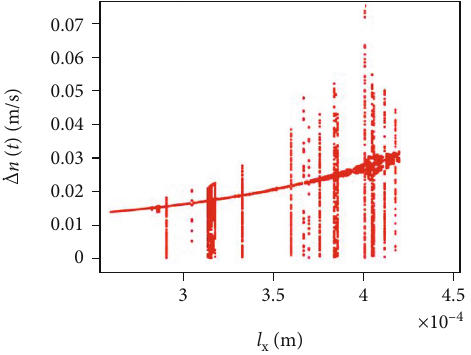
Figure 9: Bifurcation diagrams with the misalignment changing of the x direction when the misalignment in the y direction is 1 × 10 − 5